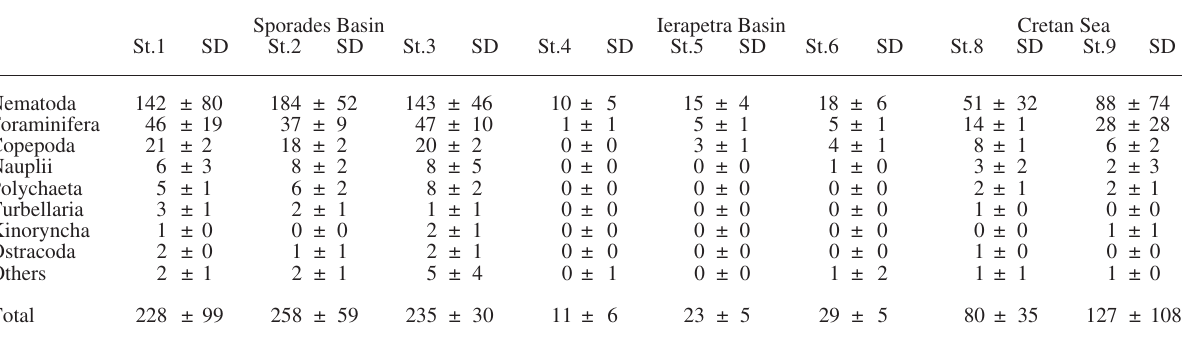
Table 2. – mean abundance (individuals per 10 cm 2 ± sd) of all meiobenthic taxa in the top 6 cm of the sediments. others include taxa (tardigrada, tanaidacea, oligochaeta, echinodermada, mollusca, Nemertina and sipuncula) which occurred only occasionally and in very low